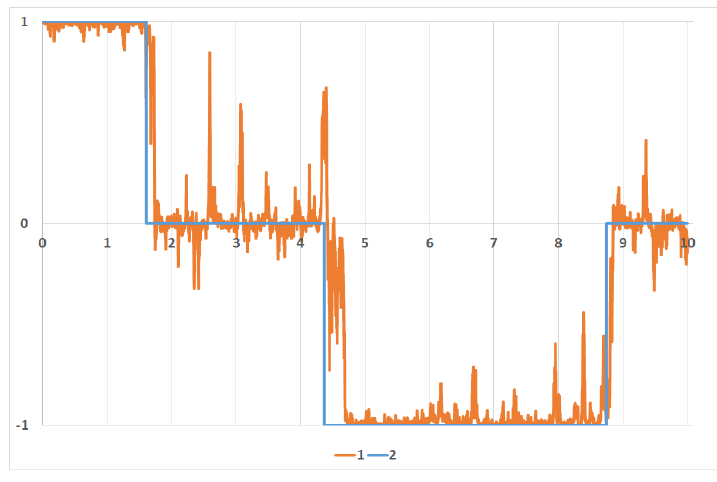
Figure 4. Trajectory and its estimate: 1 − c (cid:98) y t and 2 − cy t